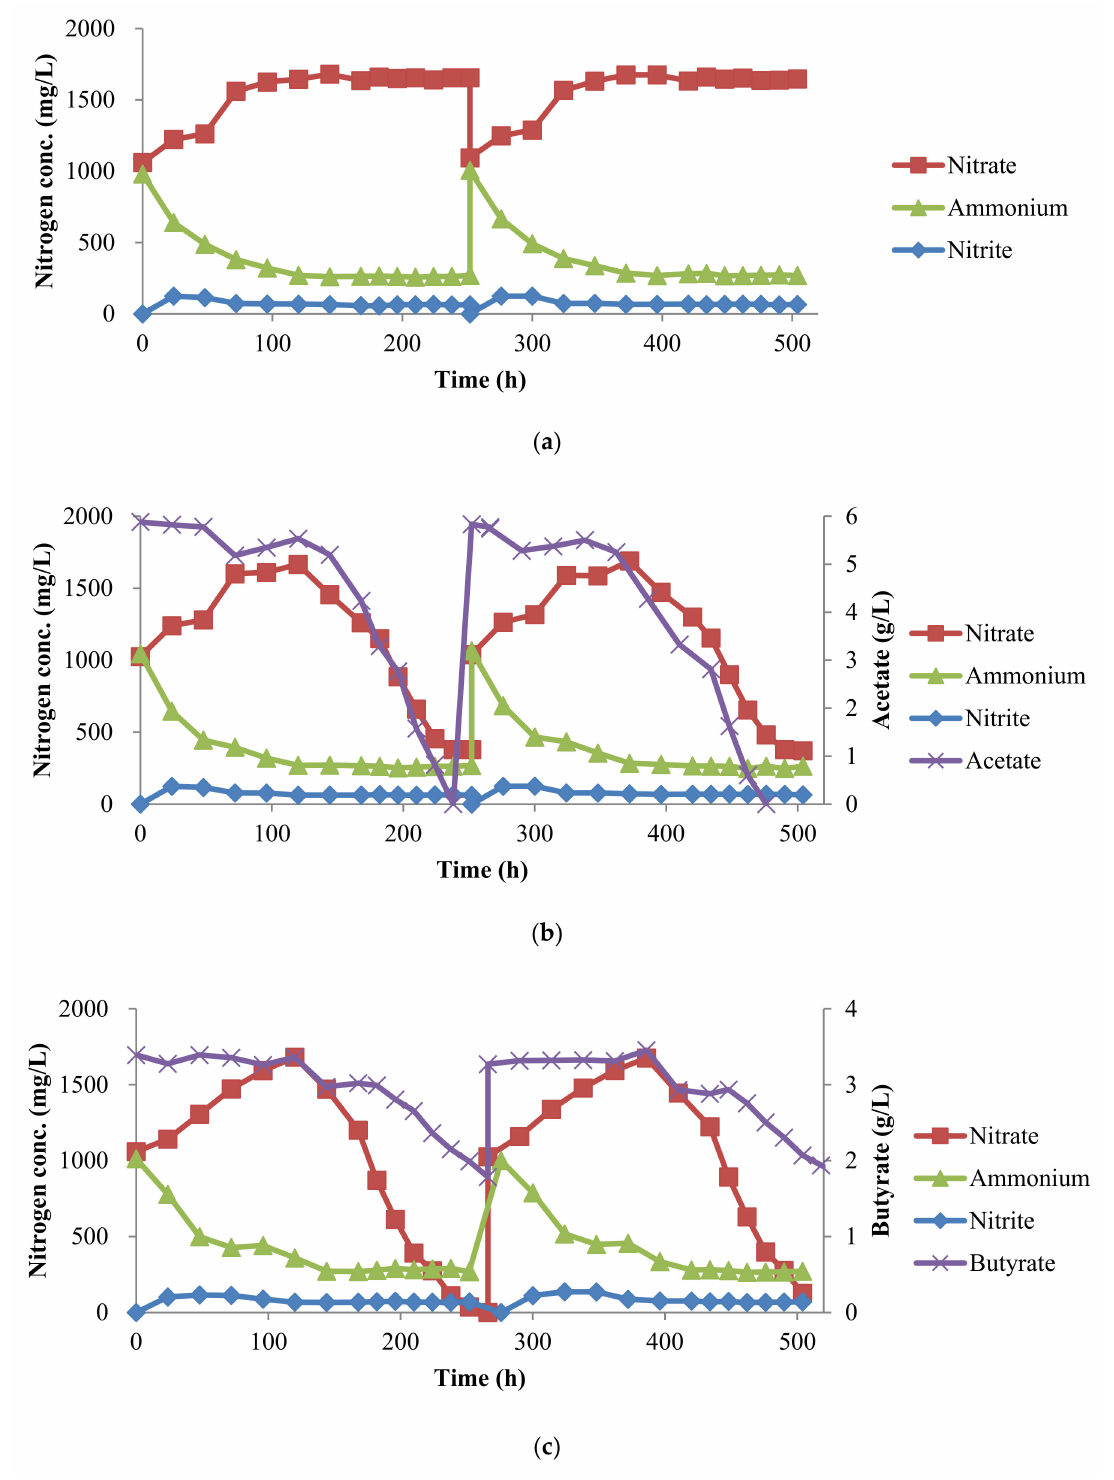
Figure 2. Nitrogen removal with ( a ) no exogenous carbon addition; ( b ) acetate addition; and ( c ) butyrate addition at COD/N =